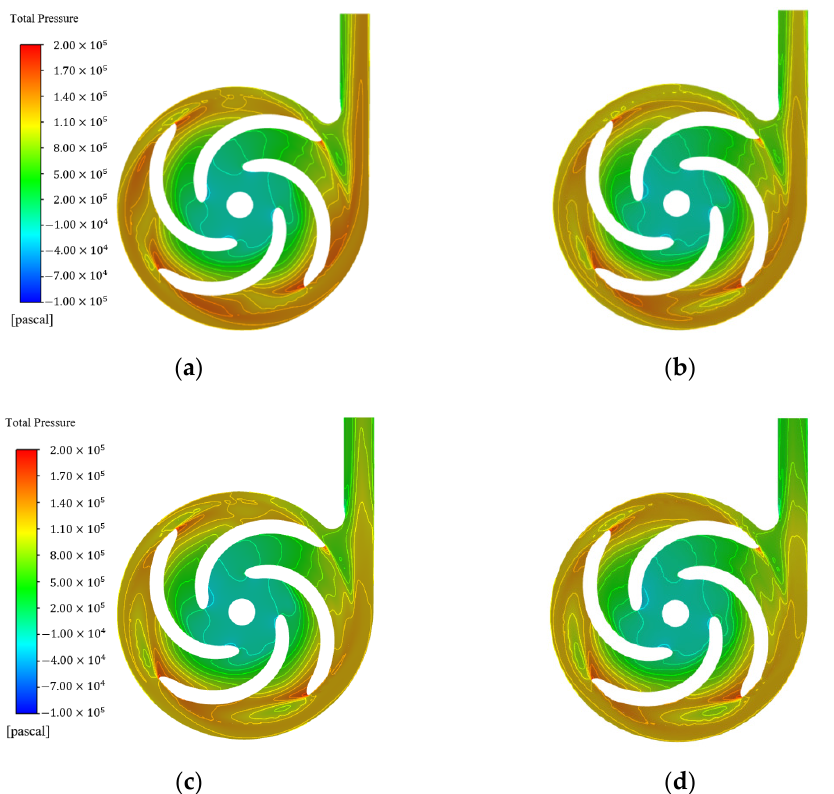
Figure 10. Pressure distribution of pump cross-section with different solid volume fractions under 1.0 Q BEP : ( a ) C V = 0%; ( b ) C V = 5%; ( c ) C V = 10%; ( d ) C V =